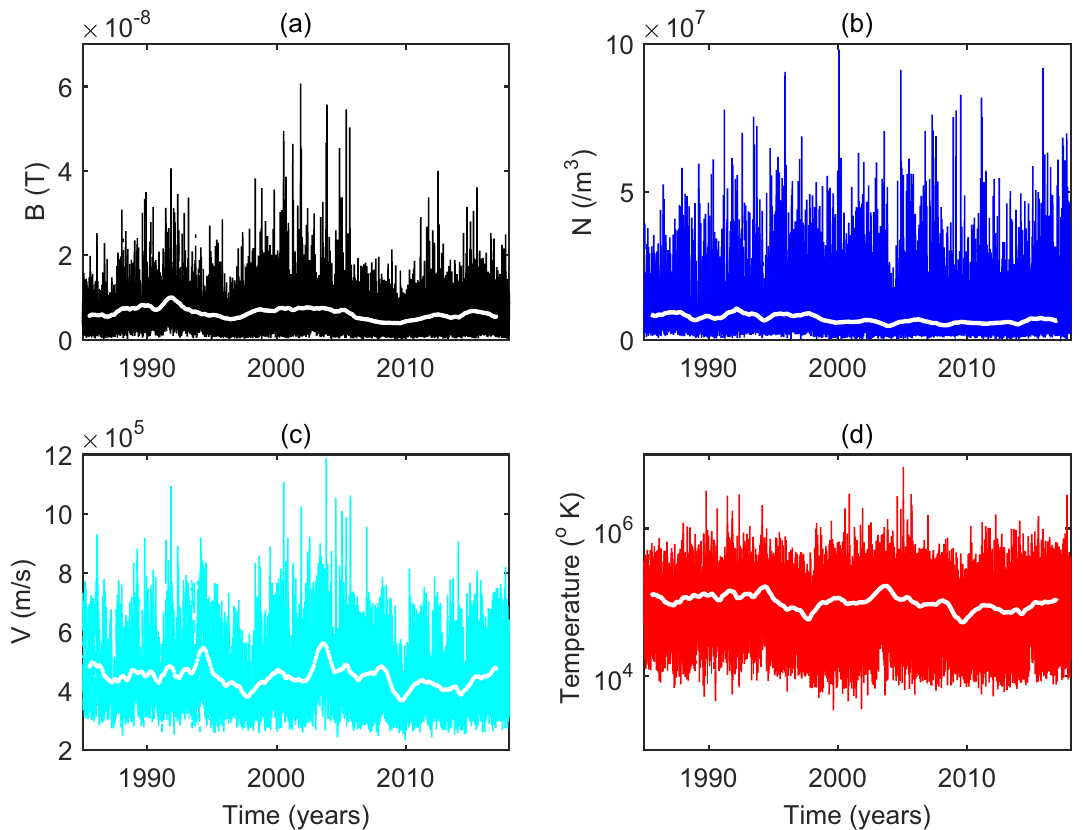
Fig. 3. Variation of (a) interplanetary magnetic field B , (b) SWP density N , (c) SWP velocity V , (d) proton temperature T p of one hour resolution at bow-shock nose for SC 22, 23, and SC 24. The white solid line plotted in each panel indicate the 13-month smooth average of corresponding